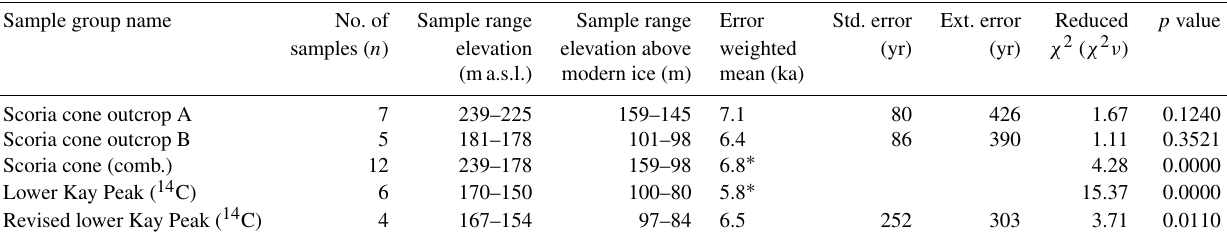
Figure 4. Exposure ages from the two scoria cone outcrops. (a) 10 Be exposure ages versus sample elevation. Error bars displayed represent internal uncertainty of AMS measurement on samples (1 σ) . (b) Very high-resolution panchromatic satellite image of the scoria cone site, credit DigitalGlobe Products, © WorldView 2 2013 DigitalGlobe, Inc., a Maxar company. Purple elevation contour lines in units of metres above sea level. Red diamonds represent the location of each sample. The separate outcrops are labelled as A and B and correspond to the upper and lower population clusters displayed in (a) , respectively. Note only 10 sample locations are displayed in (b) as some of the samples were so close to each other they were recorded with the same GPS location. For topographic profiles illustrating the scoria cone outcrops relative to the modern ice surface, see Fig. C1 (Appendix). See Table S1 for analytical data. Table 1. Summary statistics for populations of new 10 Be exposure ages from the scoria cone and previously published in situ 14 C Kay Peak ridge bedrock ages. Table includes error weighted mean exposure age, reduced χ 2 ( χ 2 ν) value and p value from each sample group. When p value > 0 . 01, the error weighted mean value and standard error are reported for that statistically significant population. When the reduced χ 2 ν p value is < 0 . 01, the arithmetic mean value indicated by ∗ is provided without an associated uncertainty because the reduced χ 2 ν and p value are not consistent with a single statistically significant population (see Results section for details). The sample elevation range above the modern ice surface is relative to the ice sheet elevation adjacent to Kay Peak ridge reported in Johnson et al. (2020) and using 80ma.s.l. as the modern ice surface elevation at the scoria cone